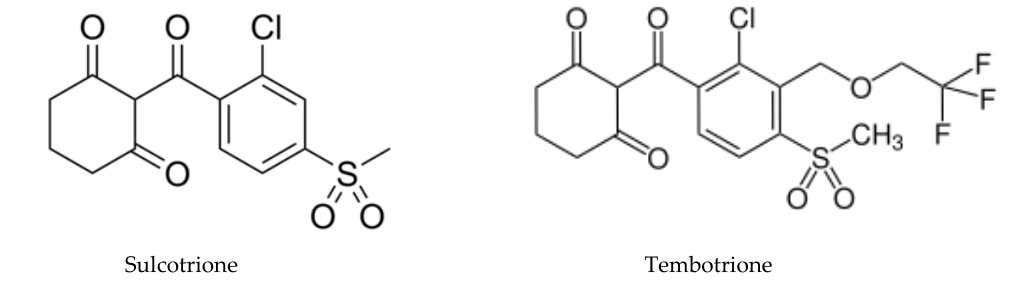
Figure 19. Leptospermone derivatives.